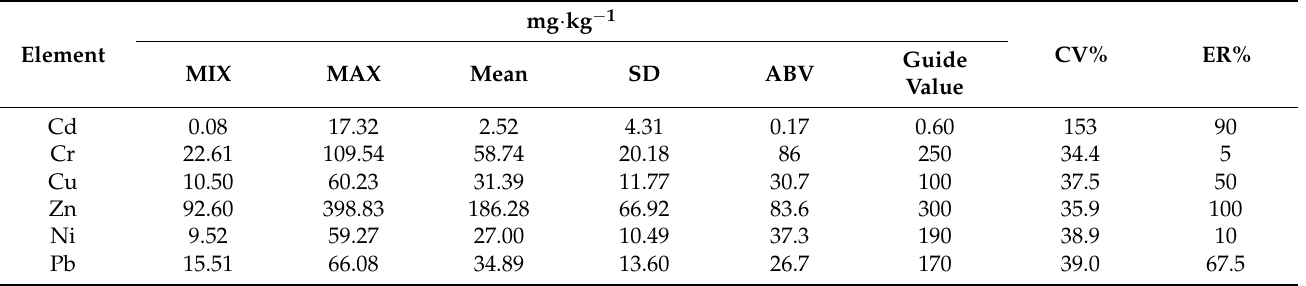
Table 1. Statistical summary of soil heavy metal concentrations (mg · kg − 1 ) in urban parks in Wuhan.